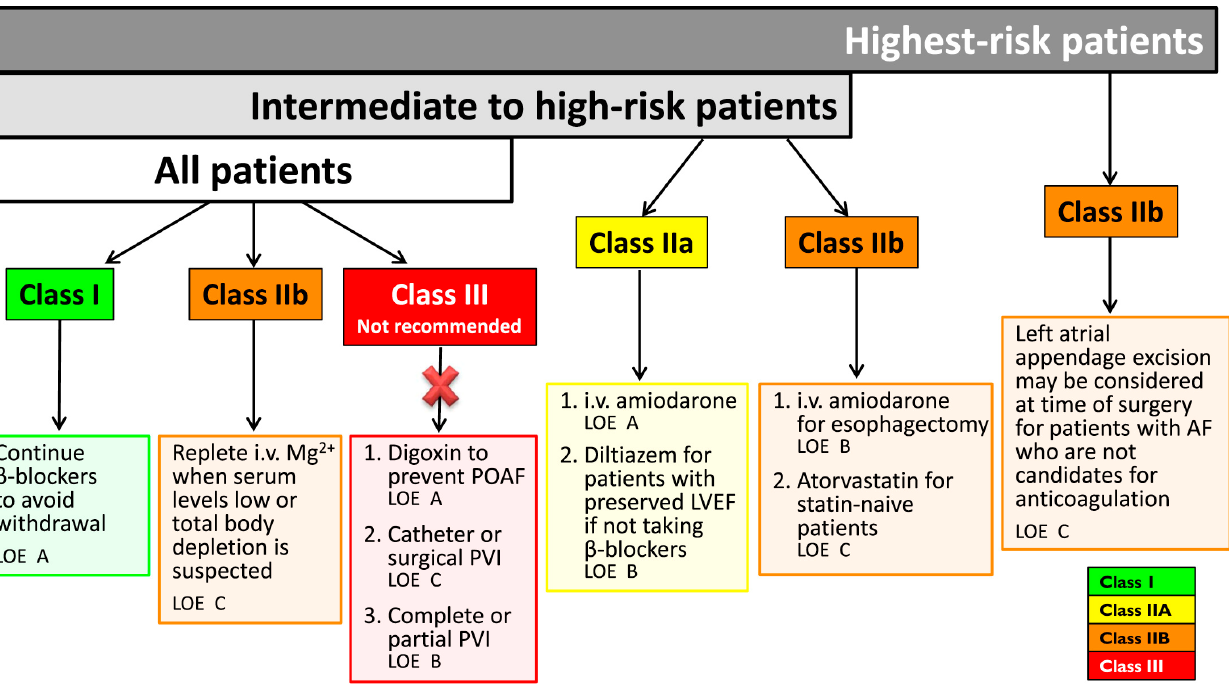
Figure 4. Indications regarding prophylaxis by AATS “ Guidelines for the prevention and management of peri-operative atrial fibrillation and flutter (POAF) for thoracic surgical procedures ”. [20].